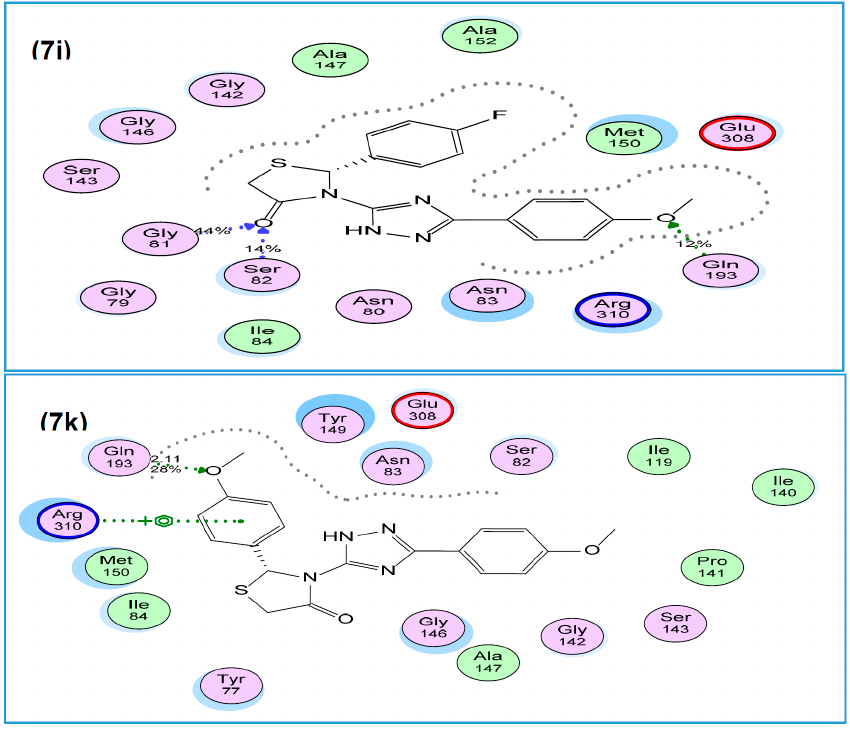
Figure 6. 2D binding mode interaction and residues involved in the recognition of moderate active Compounds 7i and 7k into the MurB binding site interaction showing the percentage of hydrogen bonds.